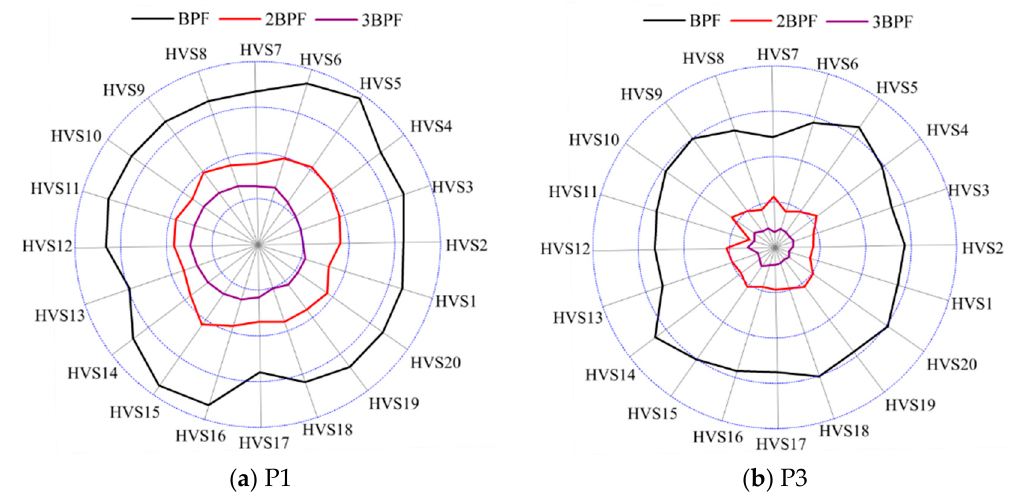
Figure 16. Distribution of pressure fluctuation components of BPF, 2BPF and 3BPF (P1 and P3).